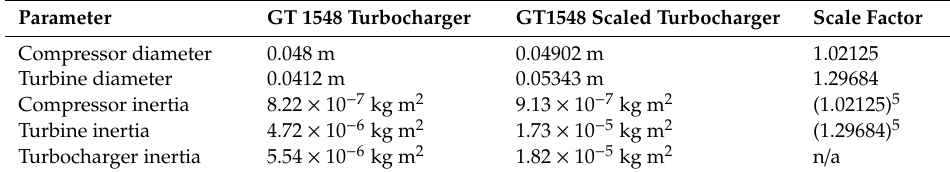
Table 9. Results of inertia testing of GT1548 turbocharger.